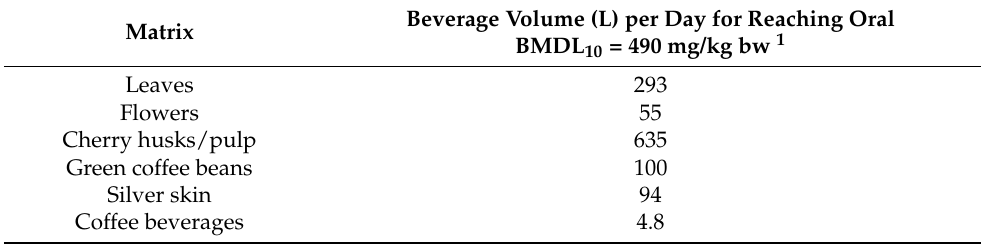
Table 5. Estimated beverage volume (L) for reaching oral BMDL 10 of 490 mg/kg bw of trigonelline.